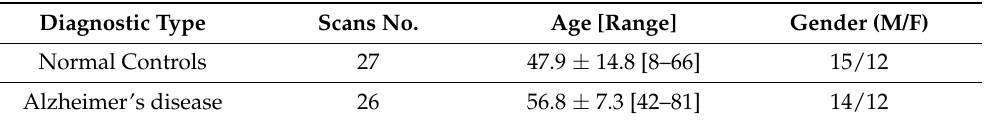
Table 3. Summary of participants in the